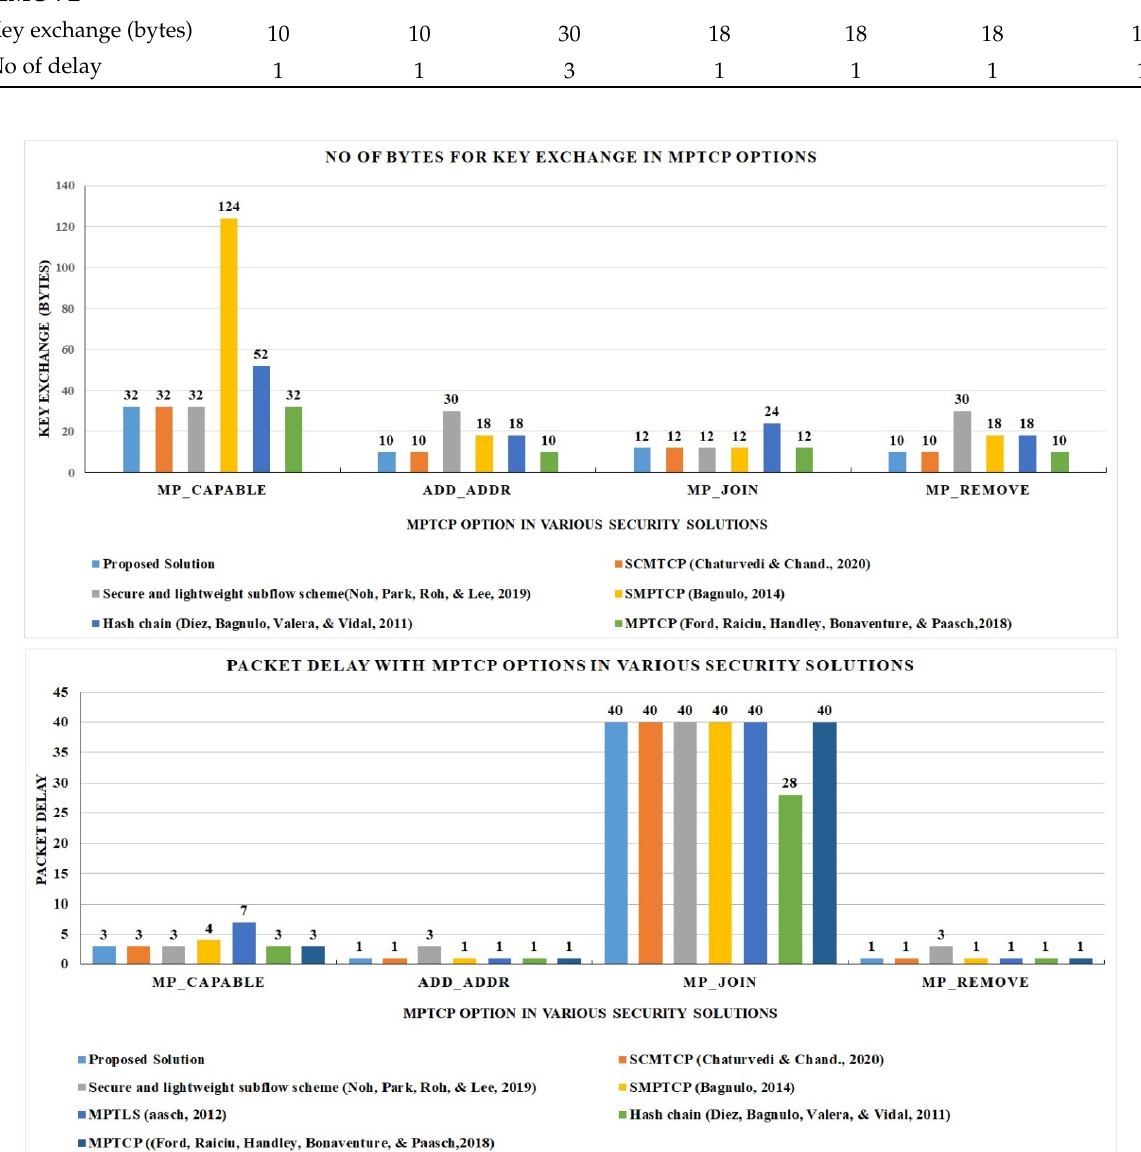
Figure 15. Comparative study of bytes required in key exchange with various MPTCP options in security solutions [17,20,23,24,33,46,47].